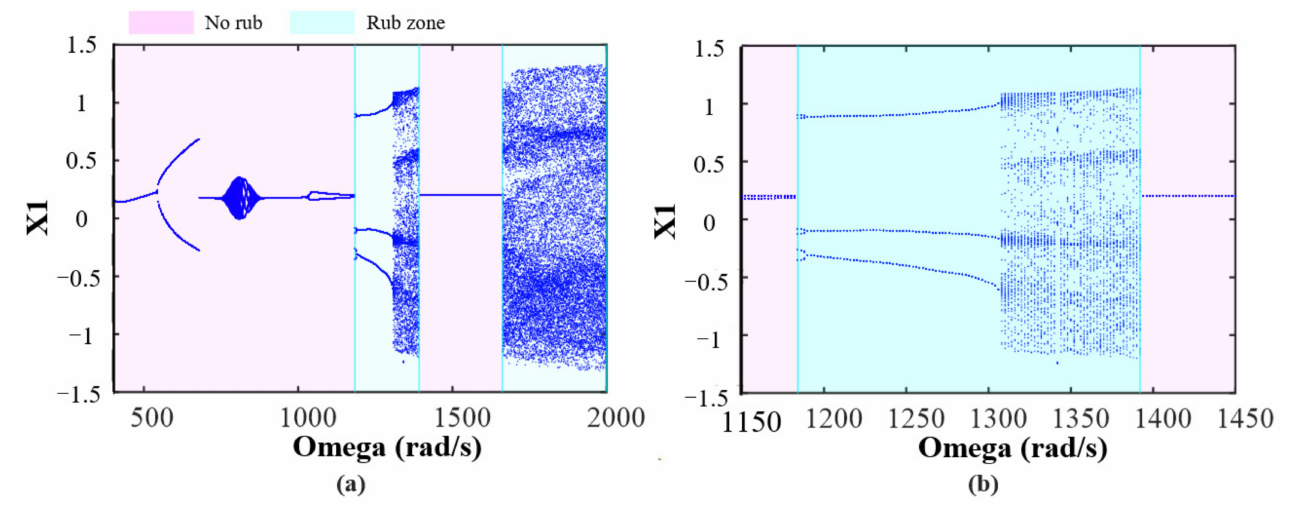
Figure 5. Bifurcation diagrams of the rotor system at the position of disc 1 for the case of disc 1 subject to rub-impact: ( a ) ω = [400~2000] rad/s; ( b ) Local bifurcation diagram.